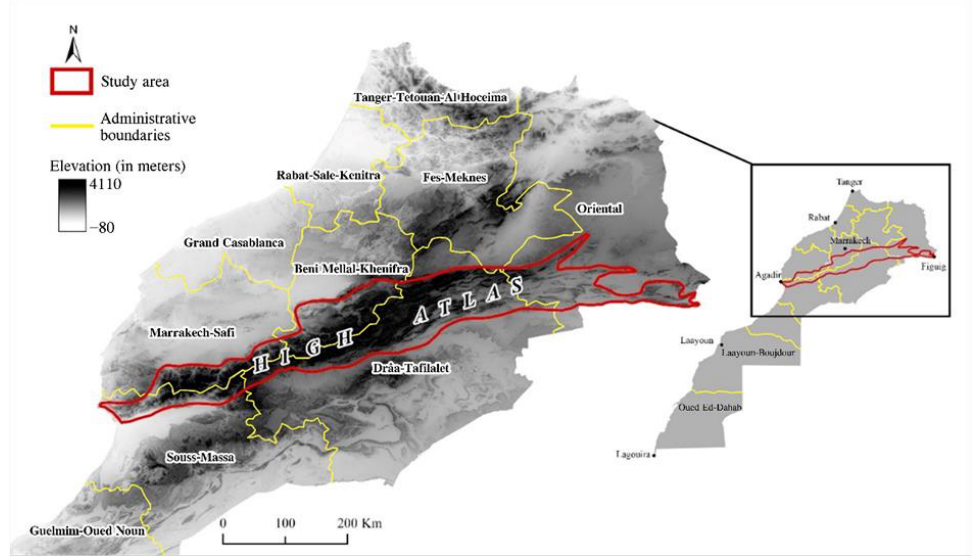
Figure 1. Study area, elevation, and boundaries of the High Atlas Mountains in Morocco (Sources: Country boundaries and digital elevation model: “Humanitarian Data Exchange”, accessed 20 January 2022, https://data.humdata.org/).